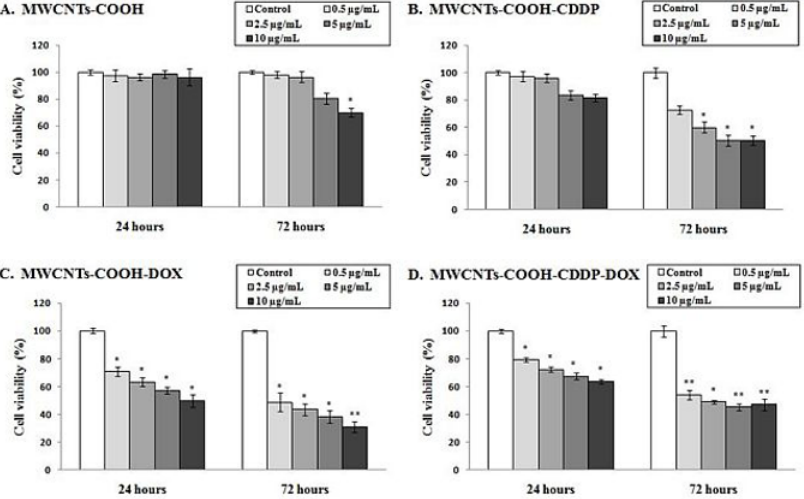
Figure 6. Cell viability. MTT test for MDA-MB 231 cells exposed to (A) MWCNTs-COOH, (B) MWCNTs-COOH-CDDP, (C) MWCNTs-COOH- DOX, (D) MWCNTs-COOH-CDDP-DOX. Values are calculated as means ± SD (n = 3) and expressed as % from controls. *P <0.05, **P < 0.01 vs.